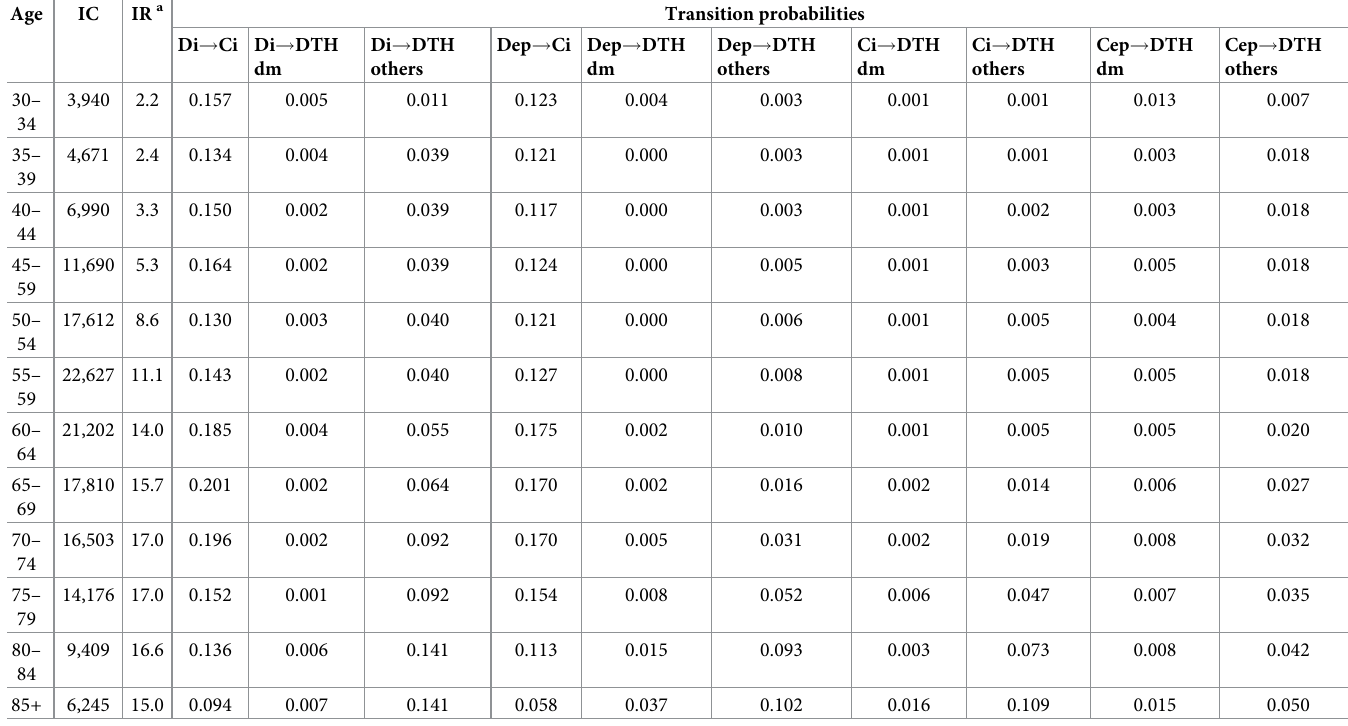
Table 2. Transition probabilities of females by age group.